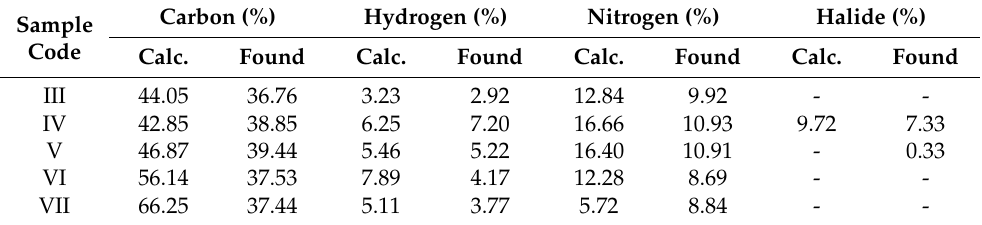
Table 1. Elemental analysis of copolymer and its quaternized salts.